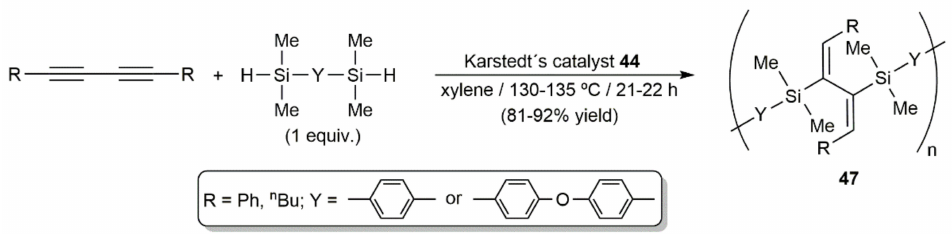
Scheme 26. Synthesis of silicon-containing polymers by Pt-catalyzed bis-hydrosilylation of